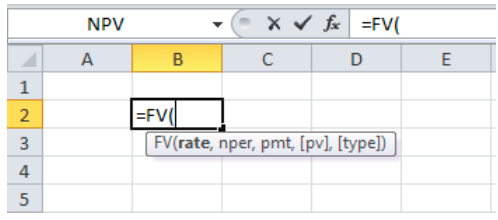
Figure 3. FV function in Microsoft Excel.